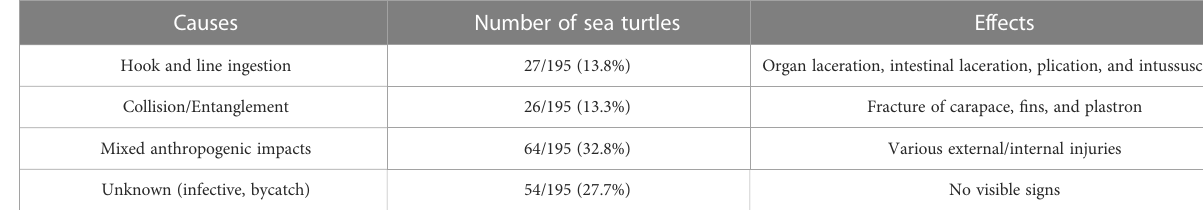
TABLE 3 Anthropogenic causes of stranding/death and their